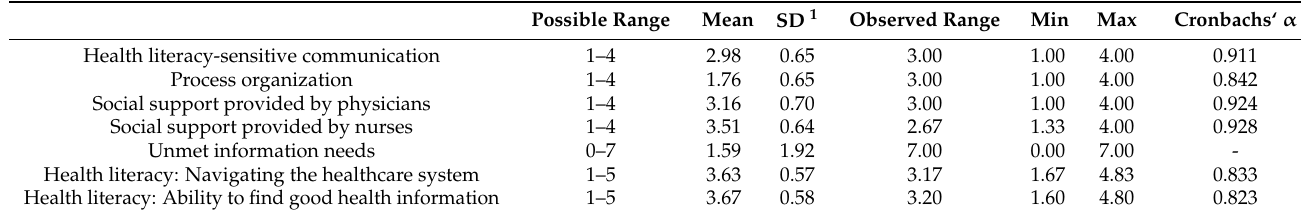
Table 4. Descriptive statistics of the latent constructs and unmet information needs.